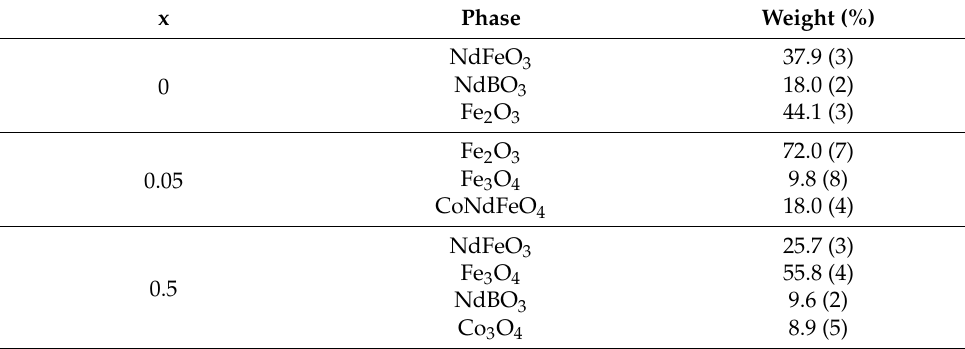
Table 2. Composition of NdFe (1 − x) Co x B according to the XRD data.